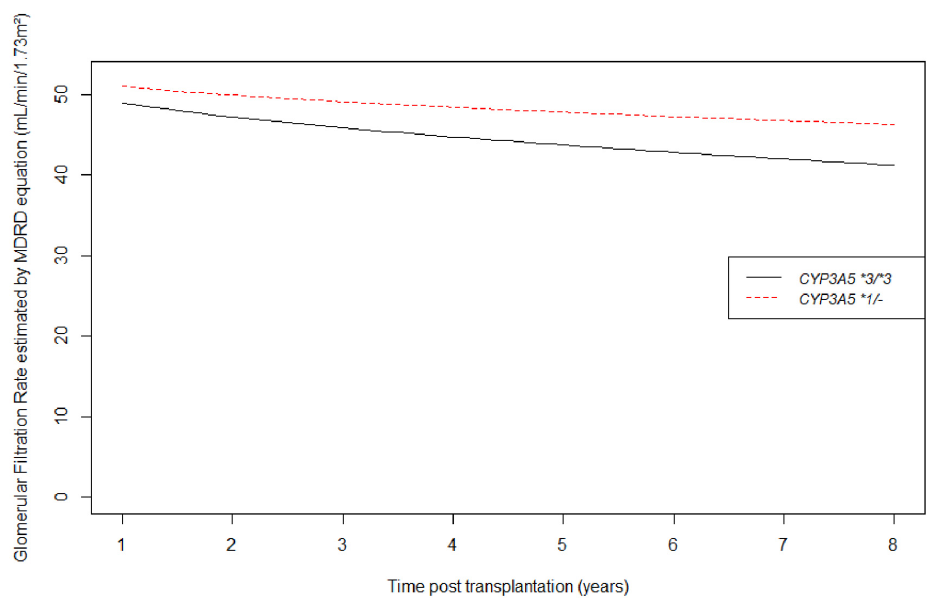
Figure 4. Longitudinal changes in estimated glomerular filtration rate by MDRD equation (mL/min/1.73 m 2 ) from 1 year post transplantation according to CYP3A5 genotype. Table 3. Linear mixed model for estimated glomerular filtration rate by MDRD equation (mL/min/1.73 m 2 ) from 1 year post